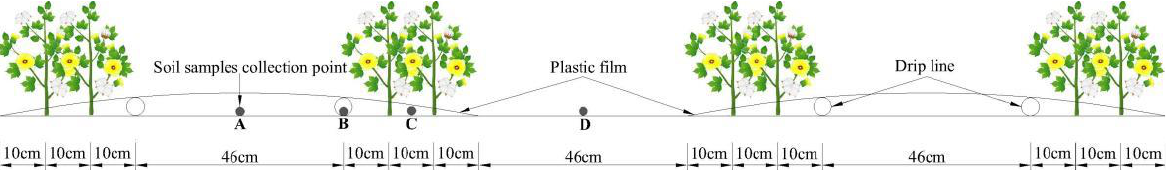
independent drip irrigation system using water from a channel with salinity of 0.7 g · L − 1 .